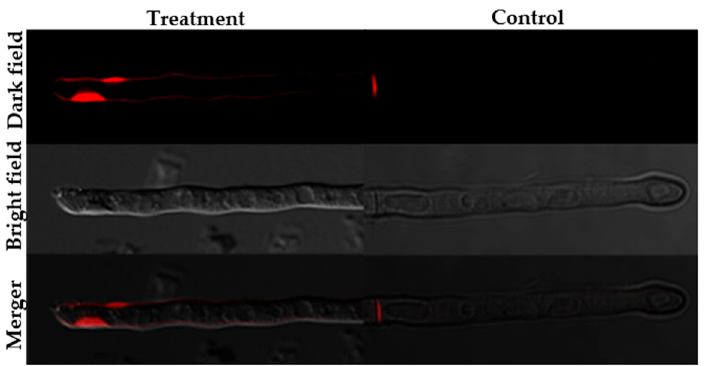
Figure 8. Accumulation of chitin at the hyphal tips of Mycosphaerella arachidicola caused by BGAP.